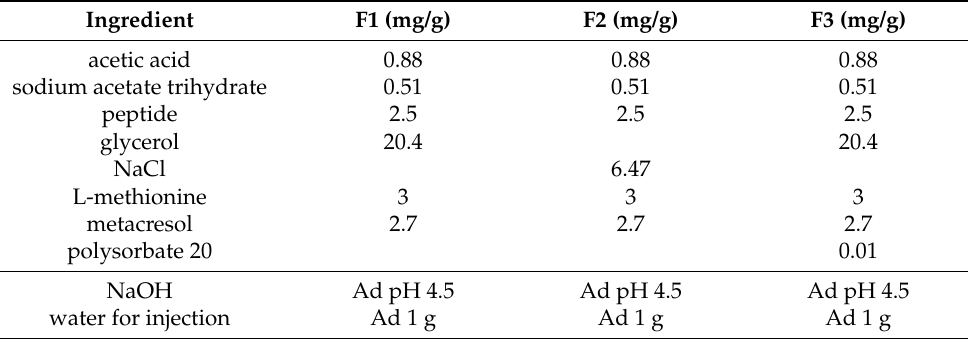
Table 1. Composition of prototype formulations (F1, F2, F3) for three-month stability